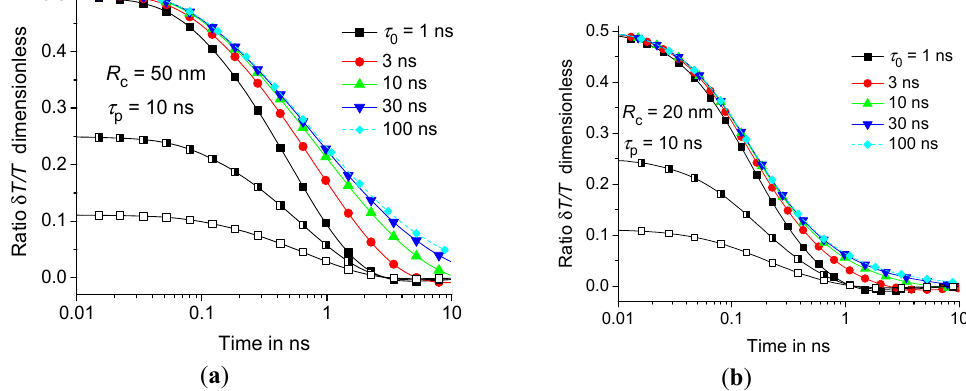
Figure 4. Time dependence of the ratio 𝛿𝑇(𝑡, 𝑅 (cid:3004) /2,0)/𝑇(cid:3560)(𝑡,𝑅 (cid:3004) /2,0) for 𝑅 (cid:3004) = 50 nm ( a ) and 20 nm ( b ) at 𝜏 (cid:3043) = 10 ns and at 𝜏 (cid:2868) = 1 ns, 3 ns, 10 ns, 30 ns, and 100 ns—the squares, circles, upwards-facing triangles, downwards-facing triangles, and diamonds, respectively; 𝜀 (cid:2868) = 1/3, 0.2, and 0.1 are represented by filled, semi-filled, and open symbols, respectively. The geometric parameters are the same as in Figure 3.